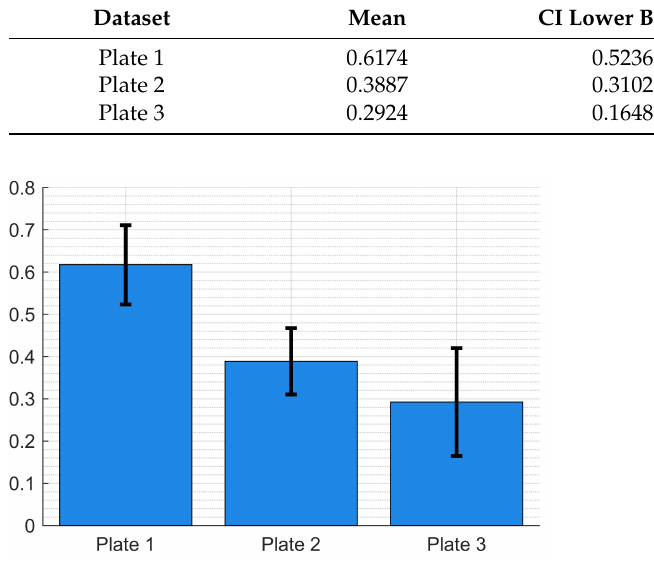
Figure 11. Plot illustrating the mean void fraction for the plates and their resp. 95%